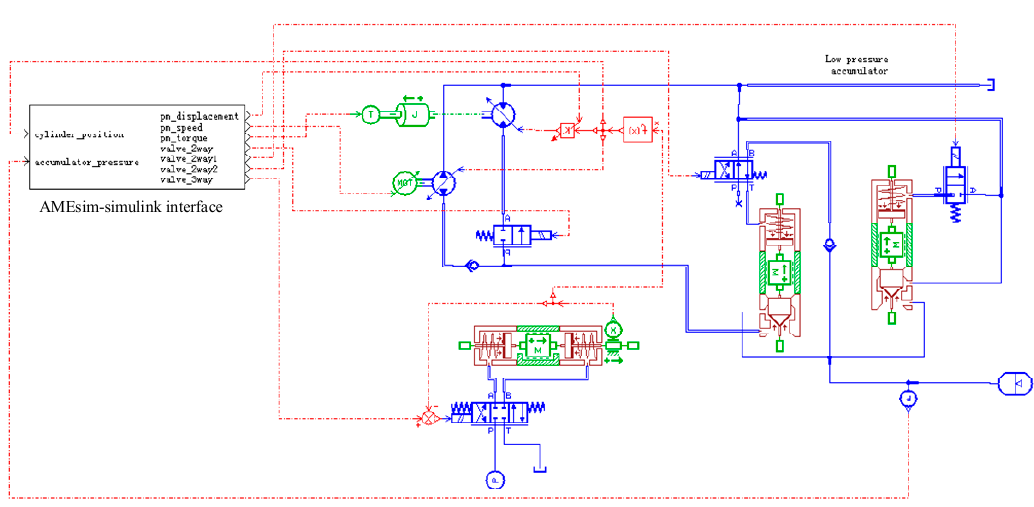
Figure 7. Hydraulic system model constructed on AMESim.